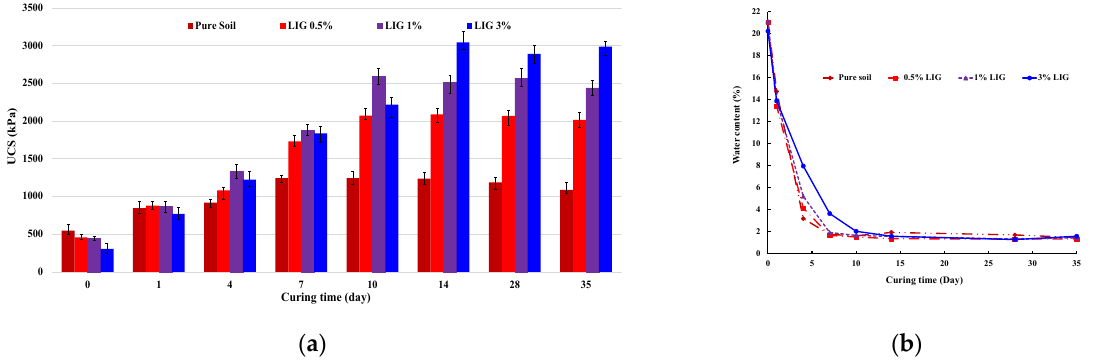
Figure 3. ( a ) Changes in UCS for the LIG-treated soil with curing time. ( b ) Variation of water content with curing time.